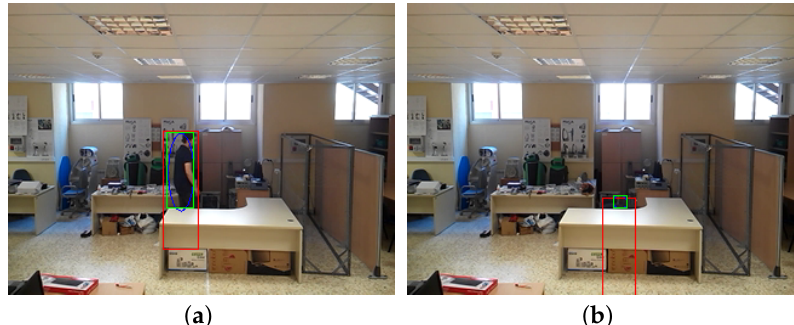
Figure 9. Example of an occlusion caused by a desk. ( a ) subject occluded by a desk; ( b ) an occluded fall behind a